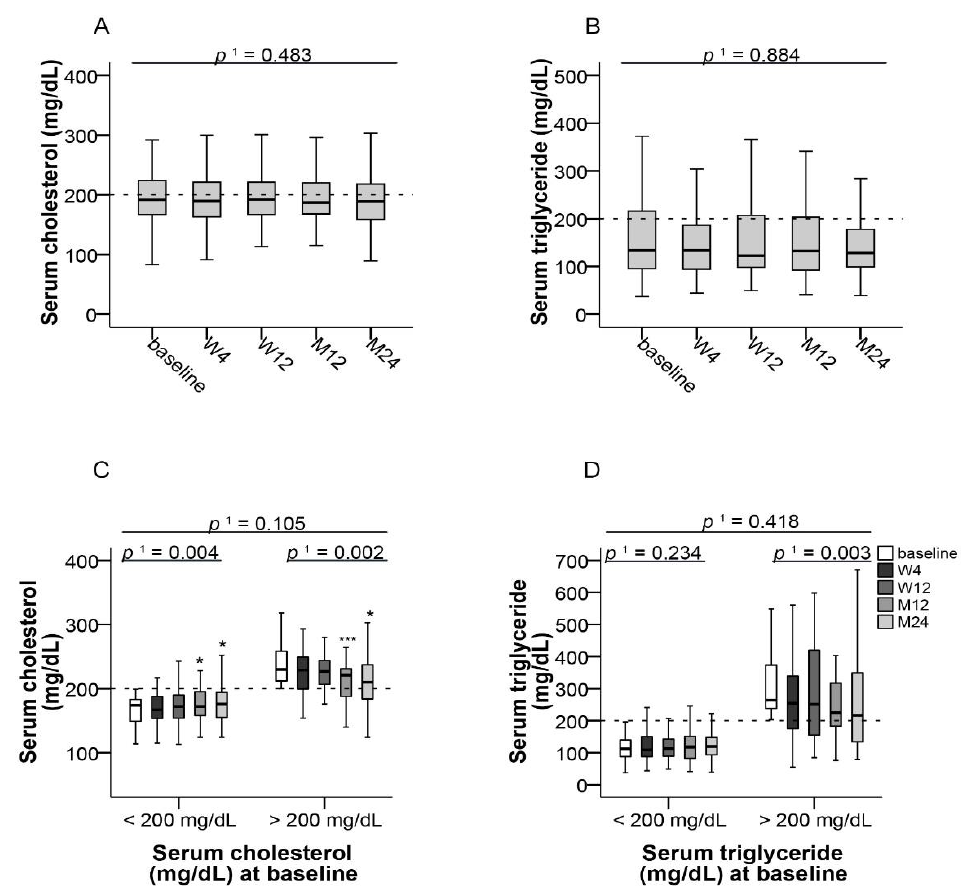
Figure 4. Blood lipids after switching to LCPT. ( A ) Boxplots show median values with 95% CI for cholesterol and ( B ) triglycerides at the baseline visit as well as at weeks 4 and 12 and at months 12 and 24; ( C ) Boxplots show median values with 95% CI for cholesterol and ( D ) triglycerides according to normal or increased respective values at baseline. 1 with Greenhouse–Geisser correction; * p ≤ 0.05, *** p ≤ 0.001; LCPT: once-daily MeltDose ® prolonged-release tacrolimus, M: month, W: week.